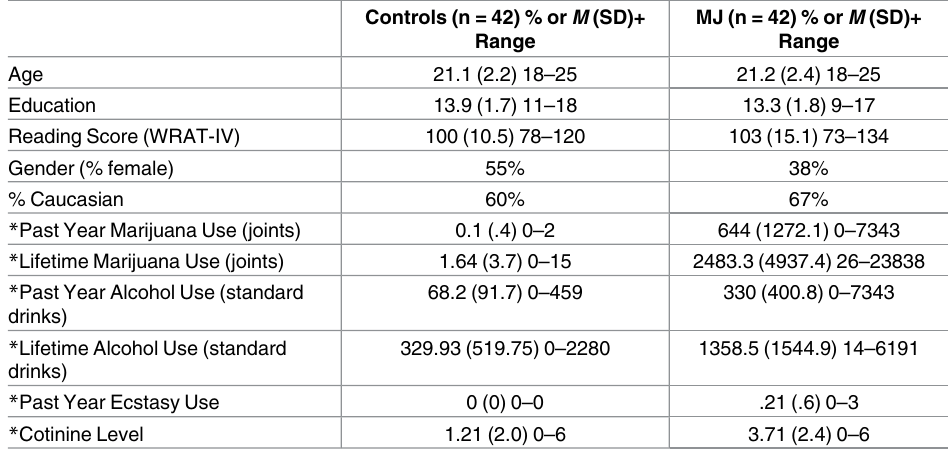
Table 1. Demographics by